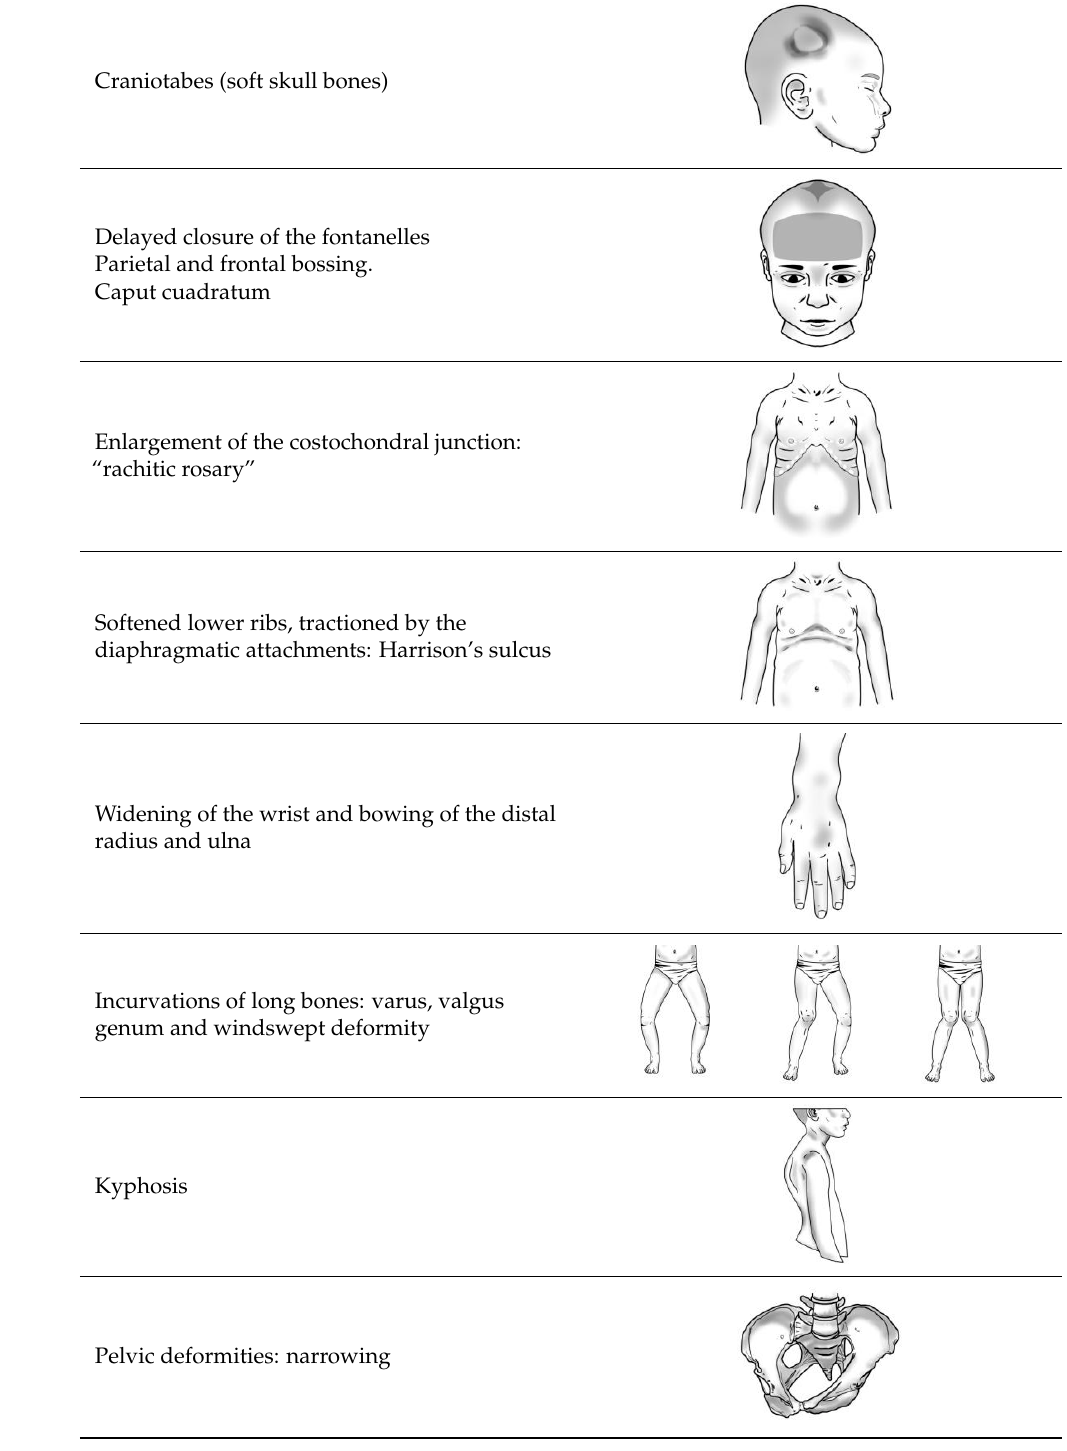
Table 4. Oral doses of vitamin D for treatment of nutritional rickets.